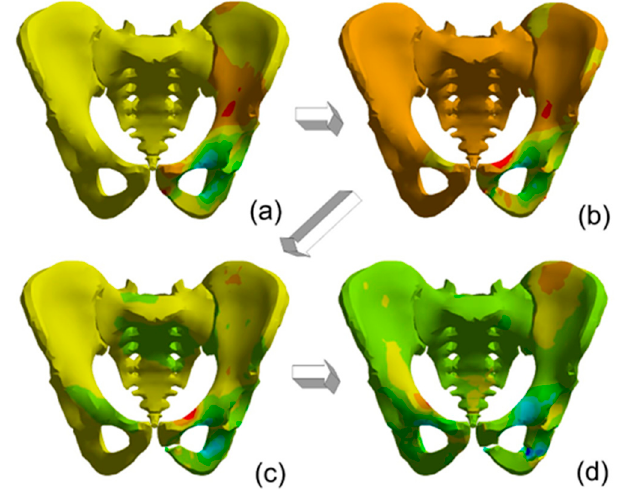
Figure 10. The steps in pelvic fracture for second support type and load impulse period time 1 ms. Map of normal stresses in next steps: ( a ) below yield stresses in cortical bone, ( b ) the advantage of compressive forces in left superior pubic ramus, ( c ) Failure of the cortical bone forces in left superior pubic ramus, ( d ) Failure of the cortical bone forces in right superior pubic ramus and the left interior ramus.